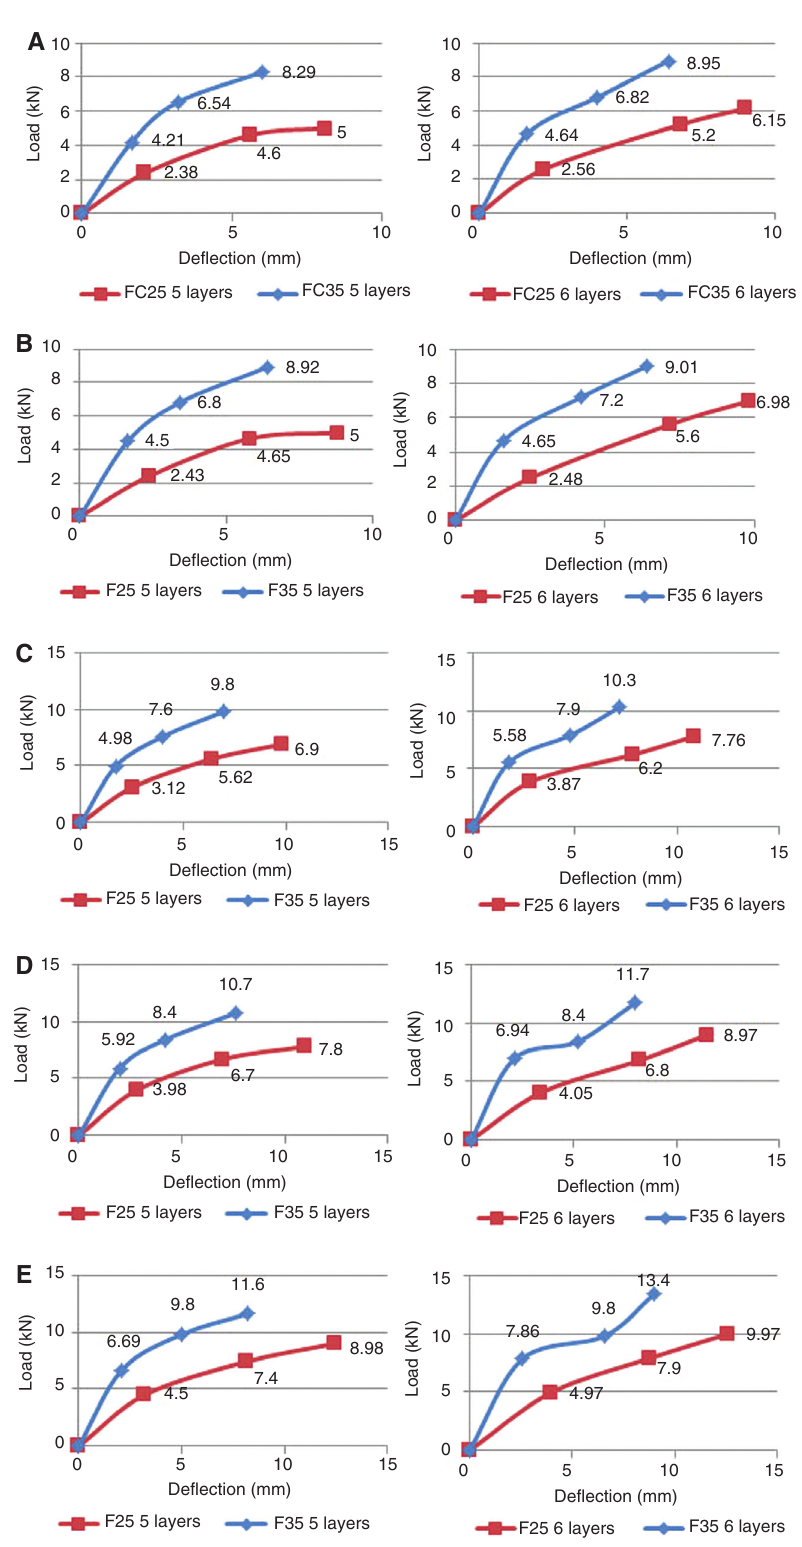
Figure 12 Load vs. mid-span deflection curve of (A) FC panels, (B) 8 m GF panels, (C) 10 m GF panels, (D) 12 m GF panels, and (E) 14 m GF